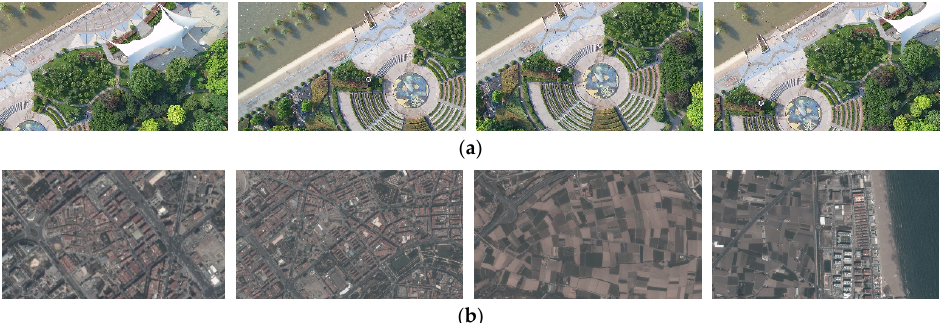
Figure 5. Typical frames from experimental data. ( a ) Unmanned aerial vehicle (UAV) video clips; ( b ) satellite video clips.